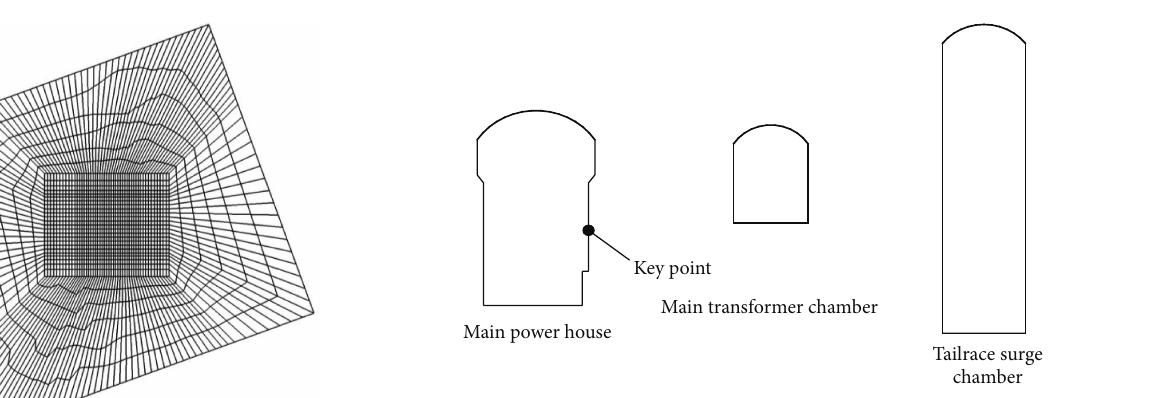
Figure 6: Cross sections of computational models with the value of 𝜃 to be 0 ∘ .